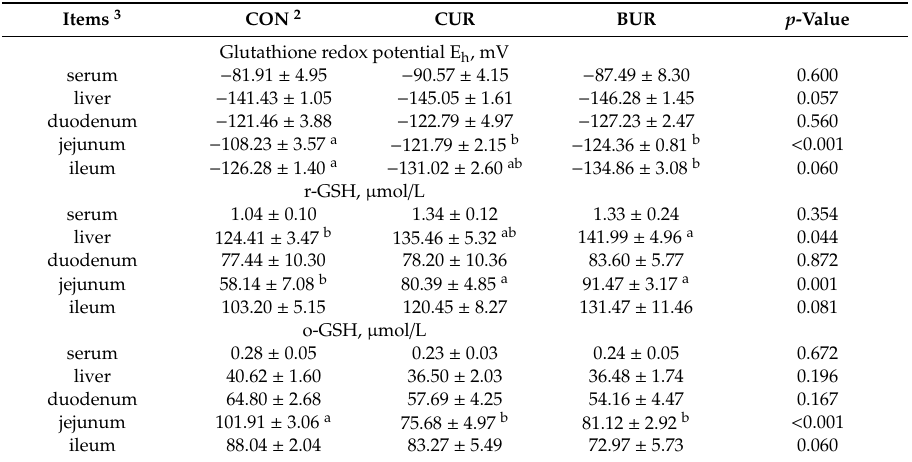
Table 5. E ff ect of curcumin and bisdemethoxycurcumin on the redox potential of serum, liver and small intestine in broilers (Experiment 2) 1